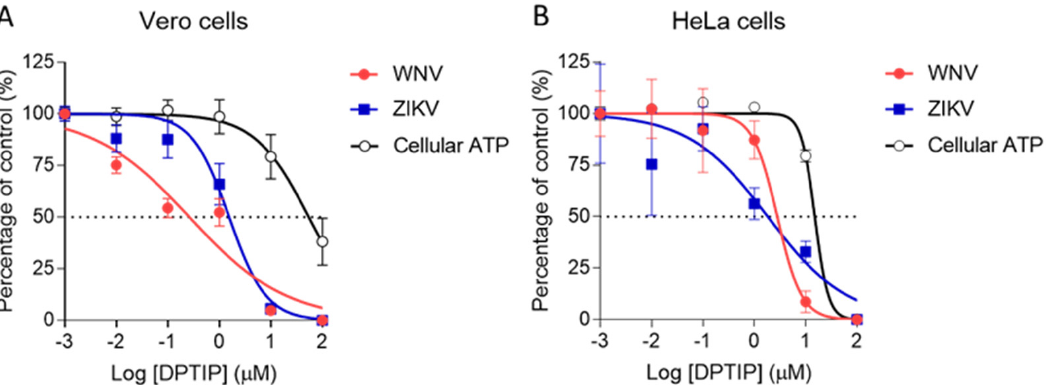
Figure 2. Antiviral activity of DPTIP against medically relevant flaviviruses. Virus yield in the supernatant of Vero ( A ) or Hela ( B ) cells infected with WNV or ZIKV (MOI of 1 PFU/cell) was determined at 24 h post-infection by standard plaque assay as described in Materials and Methods. The cytotoxicity of DPTIP was measured by determination of cellular ATP in uninfected samples. Dashed lines denote a 50% reduction. Data are expressed as mean ± SD (n = 4 to 6).